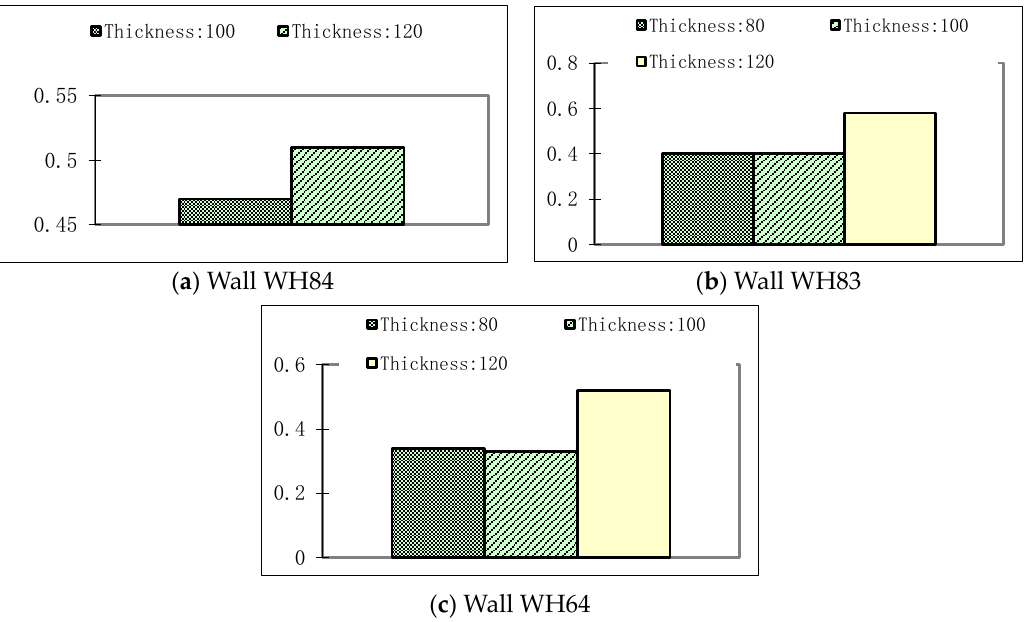
Figure 11. Comparison of δ /∆ of walls with different thickness of insulating layers.